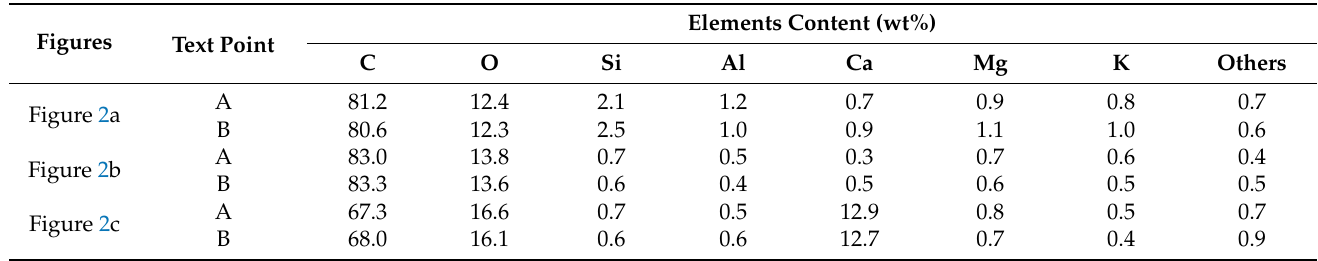
Table 2. EDX analysis (a) Biochar (b) Activated carbon and (c) 20Ca/AC-650.